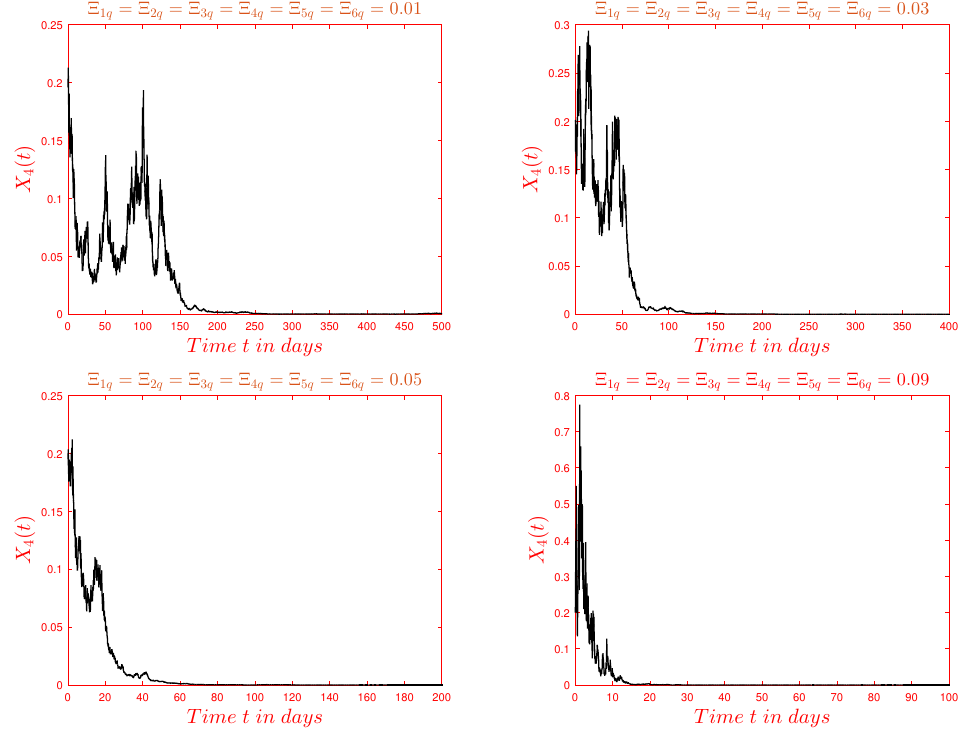
Figure 4. Numerical plot of the stochastic solution X k , k = 1,2,3,4,5,6 with different quadratic noise. The estimated deterministic values are selected from Table 2 and the linear stochastic amplitudes are chosen as follows: Ξ 1 (cid:96) = 0.07, Ξ 2 (cid:96) = 0.17, Ξ 3 (cid:96) = 0.1835, Ξ 4 (cid:96) = 0.764, Ξ 5 (cid:96) = 0.148, Ξ 6 (cid:96) =